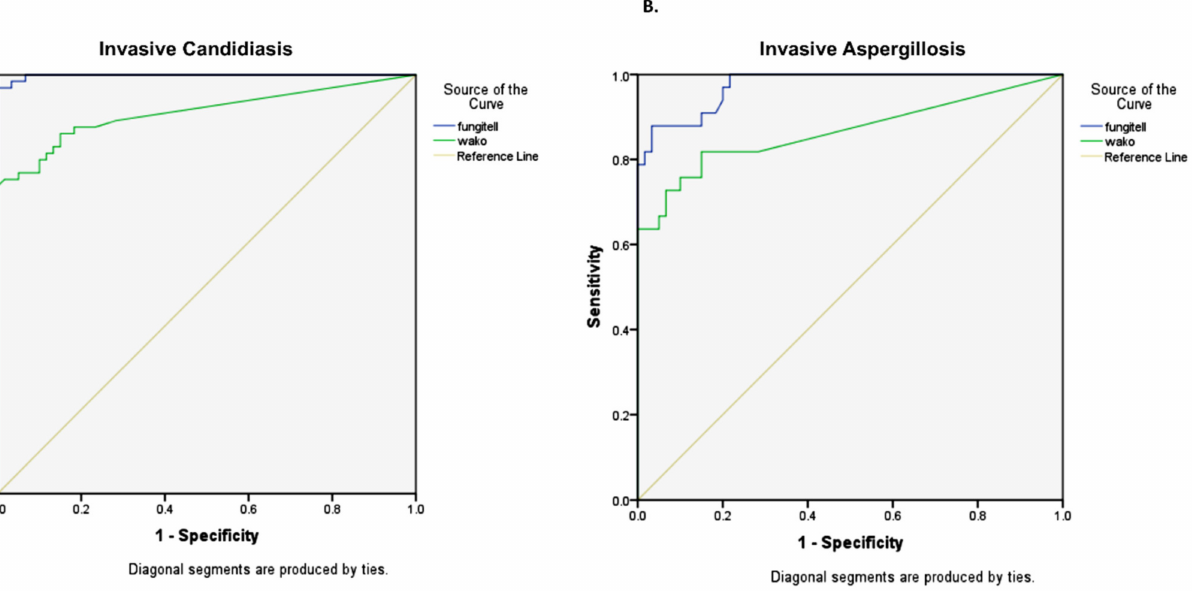
Figure 5. Receiver operating characteristics (ROC) curve showing the sensitivity and false positive rates (1–specificity) in detecting IFI (proven/ probable) using the Fungitell BDG assay (blue) and Fujifilm Wako assay (green) in patients with ( A ) Invasive candidiasis and ( B ) Invasive